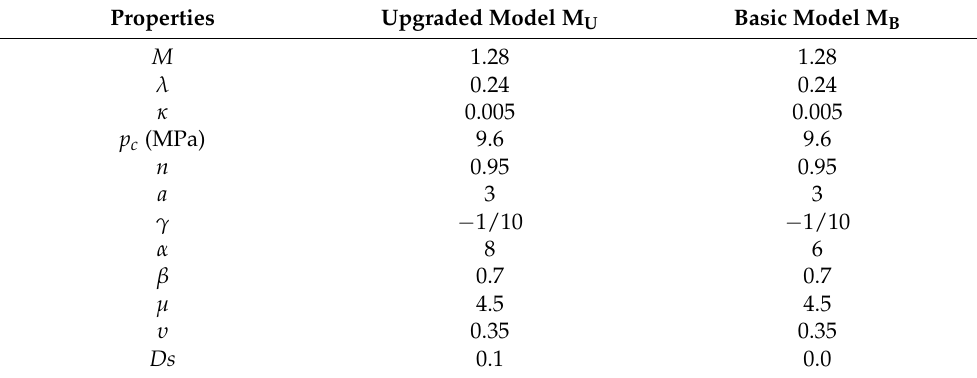
Table A2. Parameters adopted for Model Validation in Figure 8.